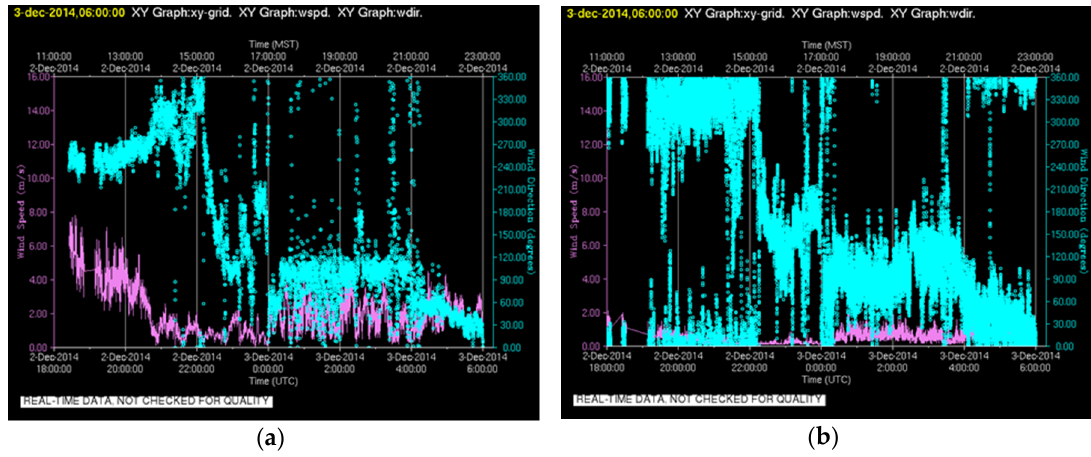
Figure 17. Plots of the GAUS measured wind speed data on 2 and 3 December 2014 at the MASCRAD Snow Field Site: ( a ) surface data outside the wind fence (surrounding environment) and ( b ) surface data inside the wind fence (distrometer environment)—both measured by NCAR Mesonet sensors.